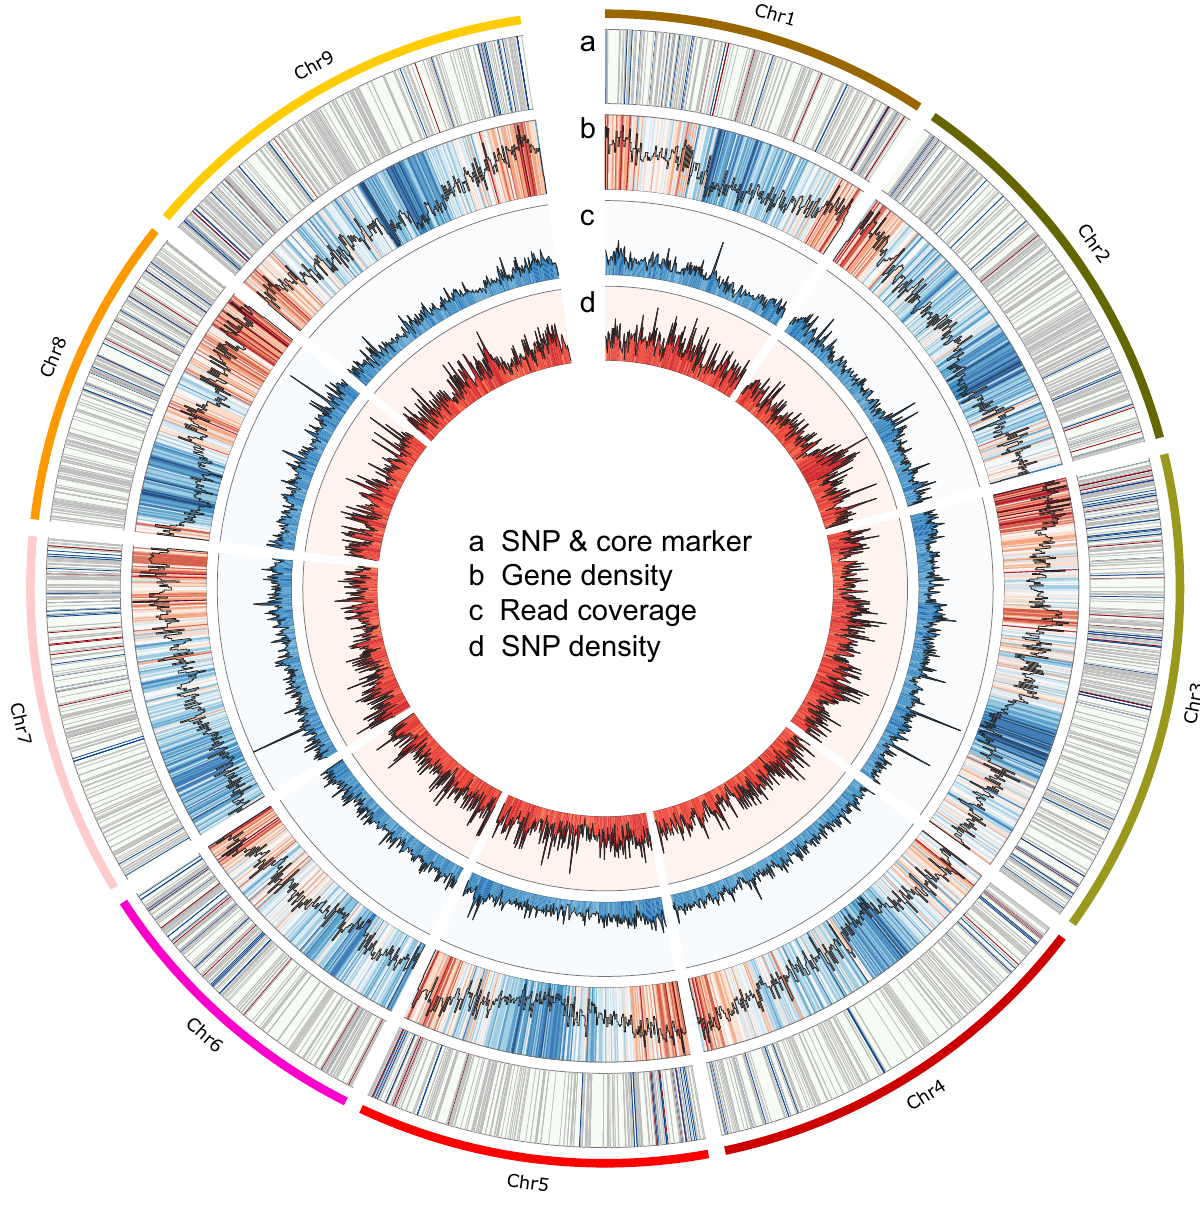
Figure 1. Genomic feature of Brassica oleracea . ( a ) Position of single nucleotide polymorphisms (SNPs) and core markers, red and blue colours indicate the position of 87 core markers and 348 candidate markers, respectively. Grey colour indicates 2941 SNPs. ( b ) Gene density of annotation B. oleracea var. oleracea ‘BOL’ release 41, red and blue indicate gene-rich and gene-poor regions, respectively. ( c ) Read coverage of genotype- by-sequencing (GBS); deep blue indicates over 75% and light blue indicates less than 25%. ( d ) SNP density, Deep red indicates over 75% and light red indicates less than